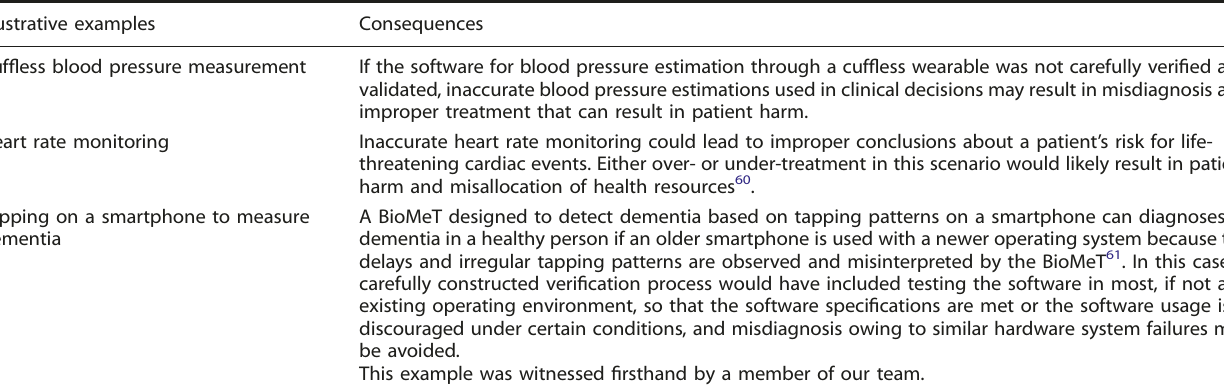
Table 9. Illustrative examples of consequences where V3 evaluation does not